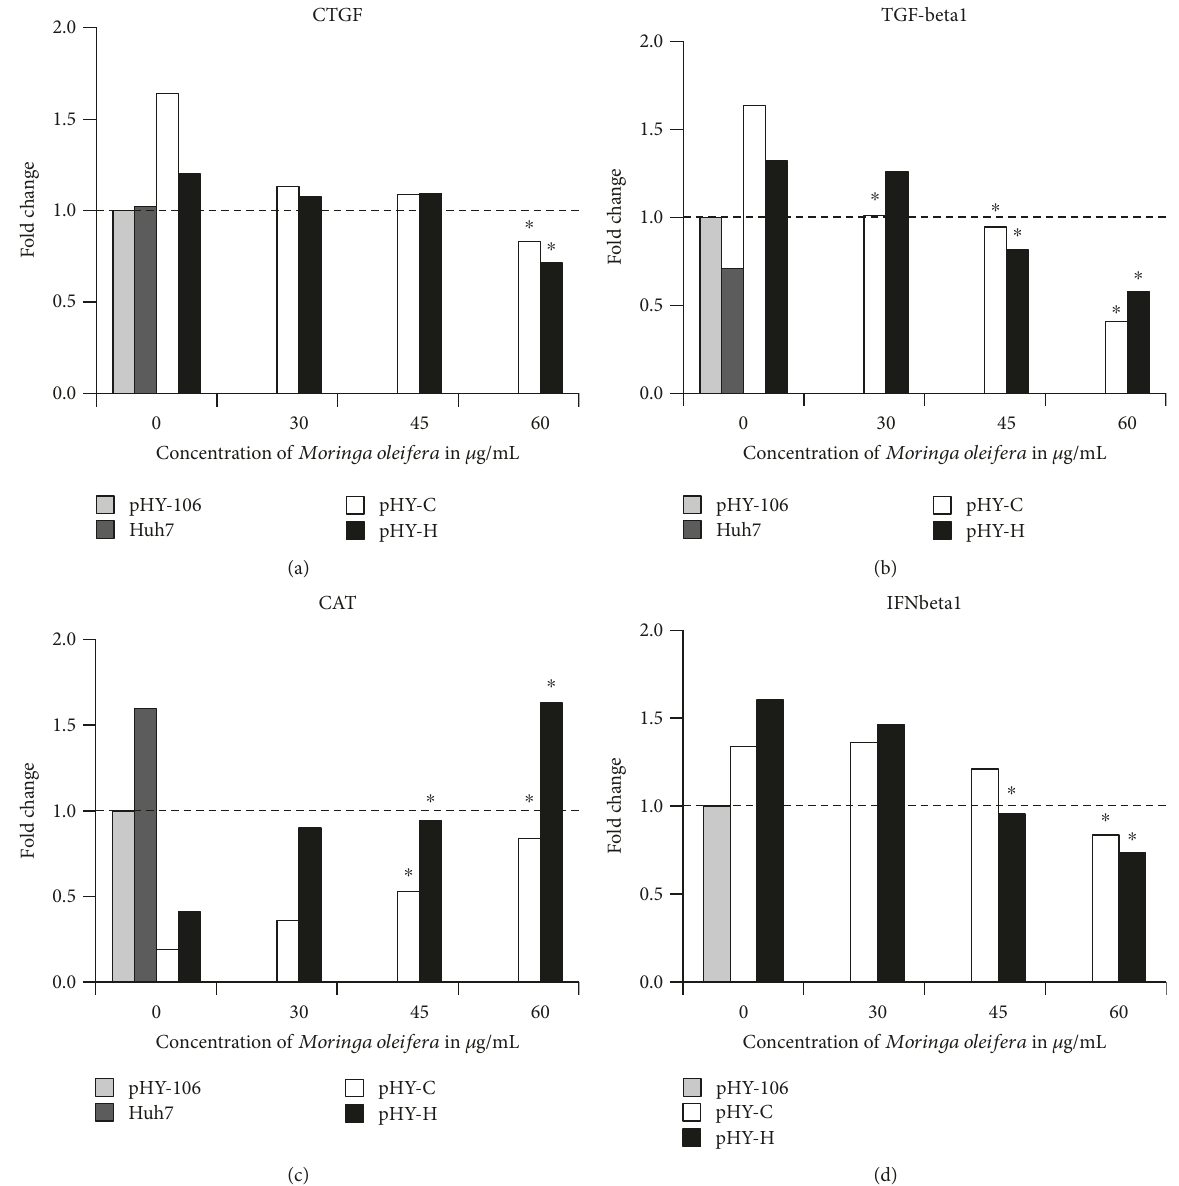
Figure 3: (a) CTGF , (b) TGF-beta1 , (c) CAT , and (d) IFNbeta1 gene expressions of Huh7 cells transfected with genotype C (white bars) or H (black bars) of HBV and treated with Moringa oleifera . Fold change (2 − ΔΔ Ct ) was calculated with reference data without treatment and plasmid pHY-106 (without HBV genome). ∗ p < 0 05 based on Δ Ct